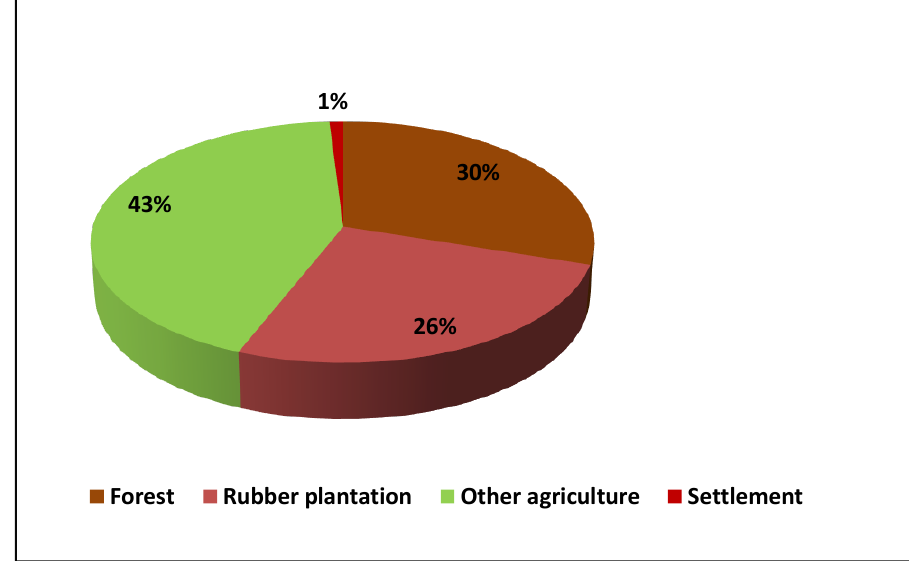
Figure 2. Land uses in Buntoi village [16].